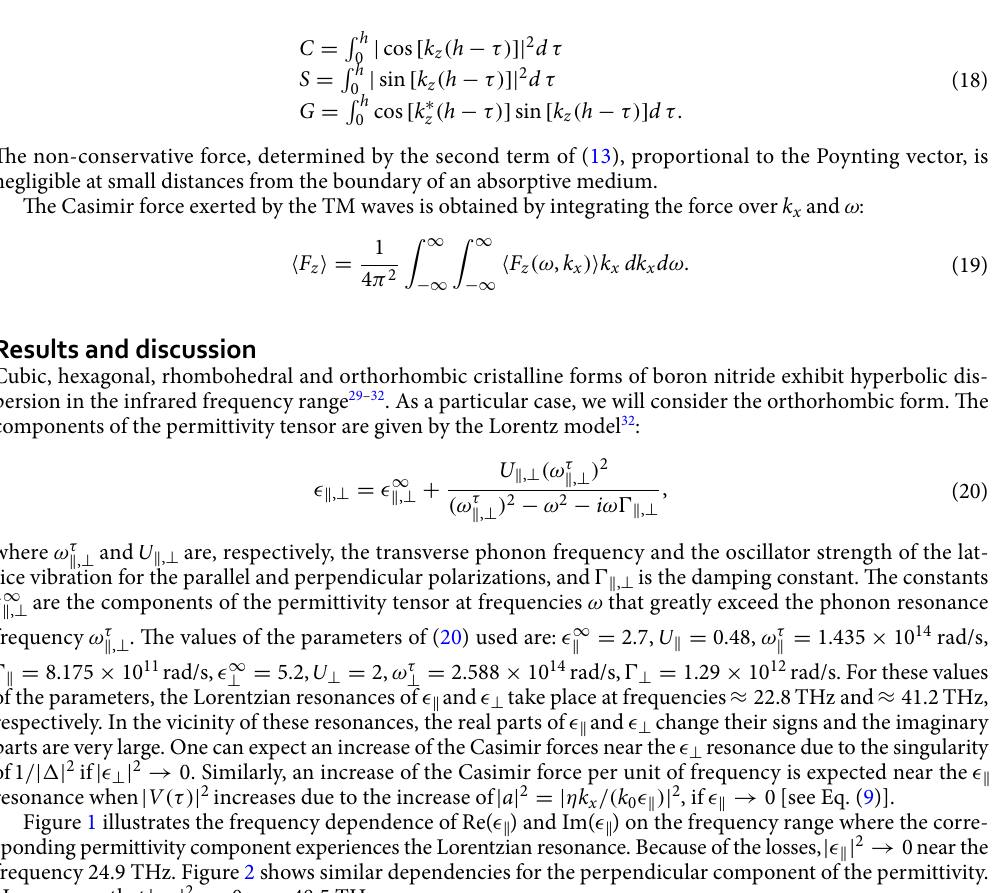
) (black solid line), Im( ǫ (cid:31)